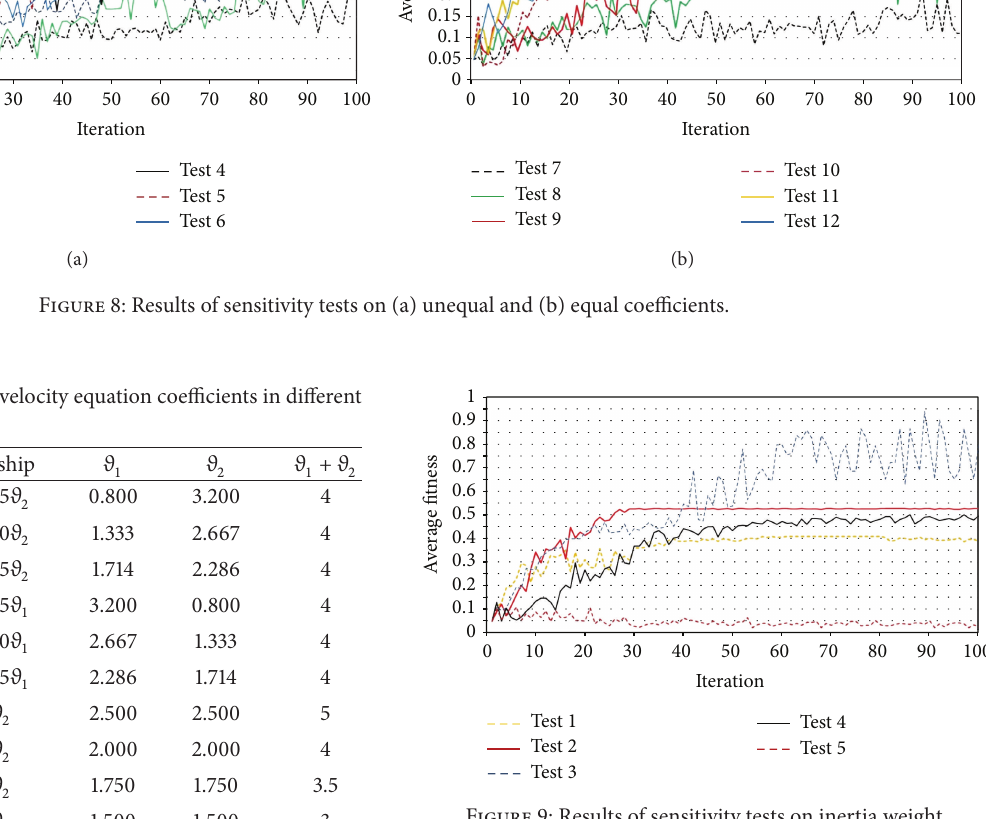
Figure 9: Results of sensitivity tests on inertia